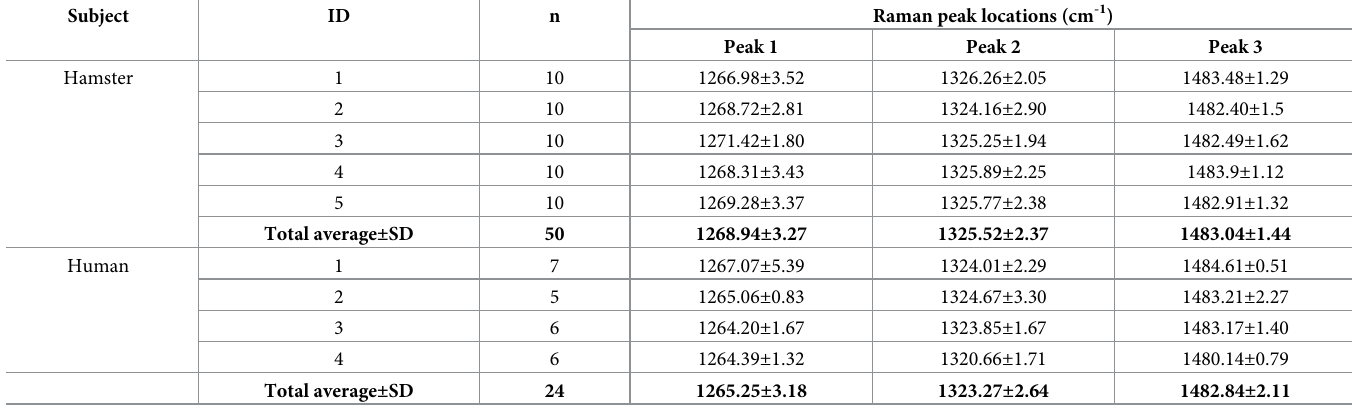
Table 1. Summary of characteristic Raman peak locations of O . viverrini eggs obtained from the fecal specimens of 5 hamsters and 4 human subjects. Each number represents an averaged peak location ± standard